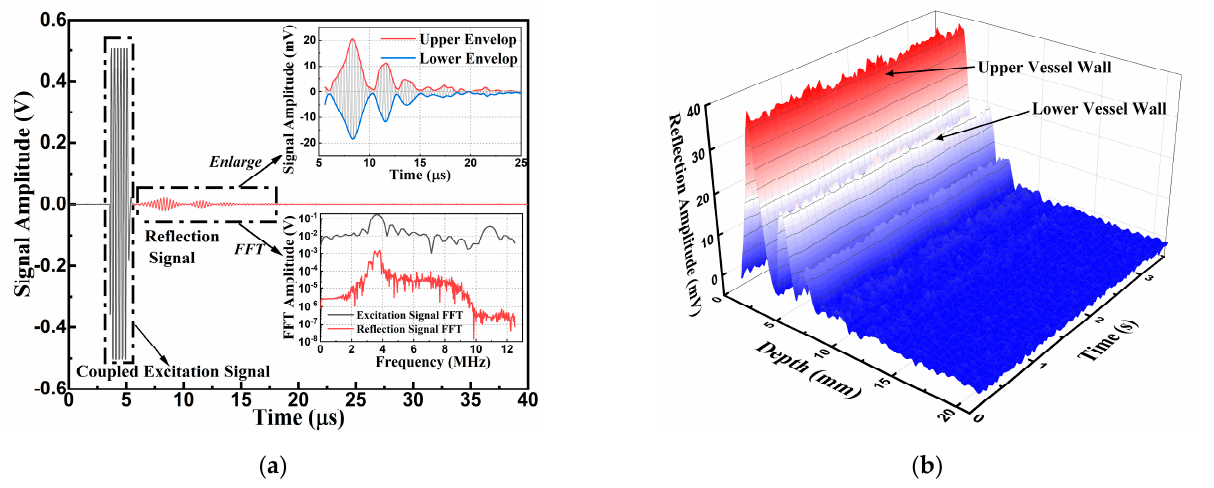
Figure 10. ( a ) Pulse-echo signals of the single acquisition and data process in MATLAB. ( b ) The three-dimensional view of the receiving signal amplitude of continuous recording.